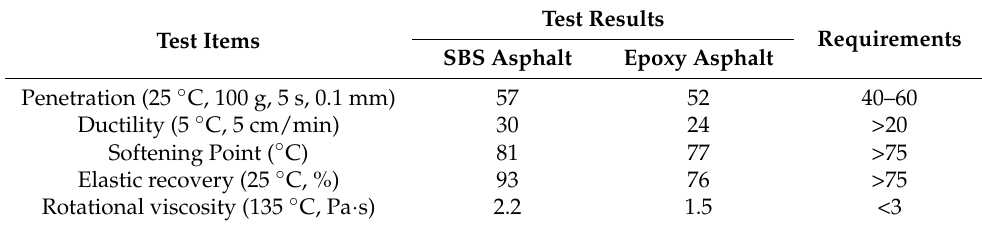
Table 2. Detection results of main technical indexes of grid coating.